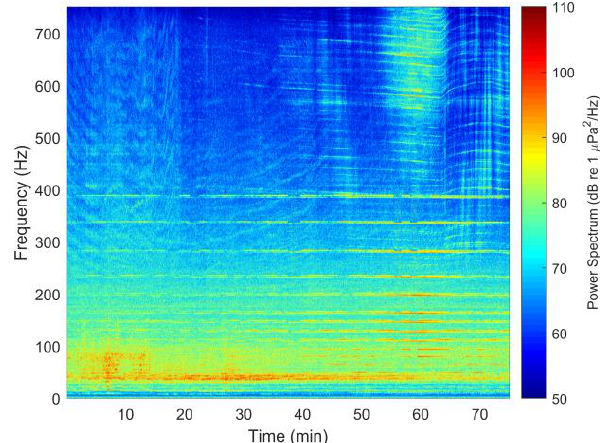
Figure 8. Time–frequency diagram of measured signal. Figure 8. Time – frequency diagram of measured signal.